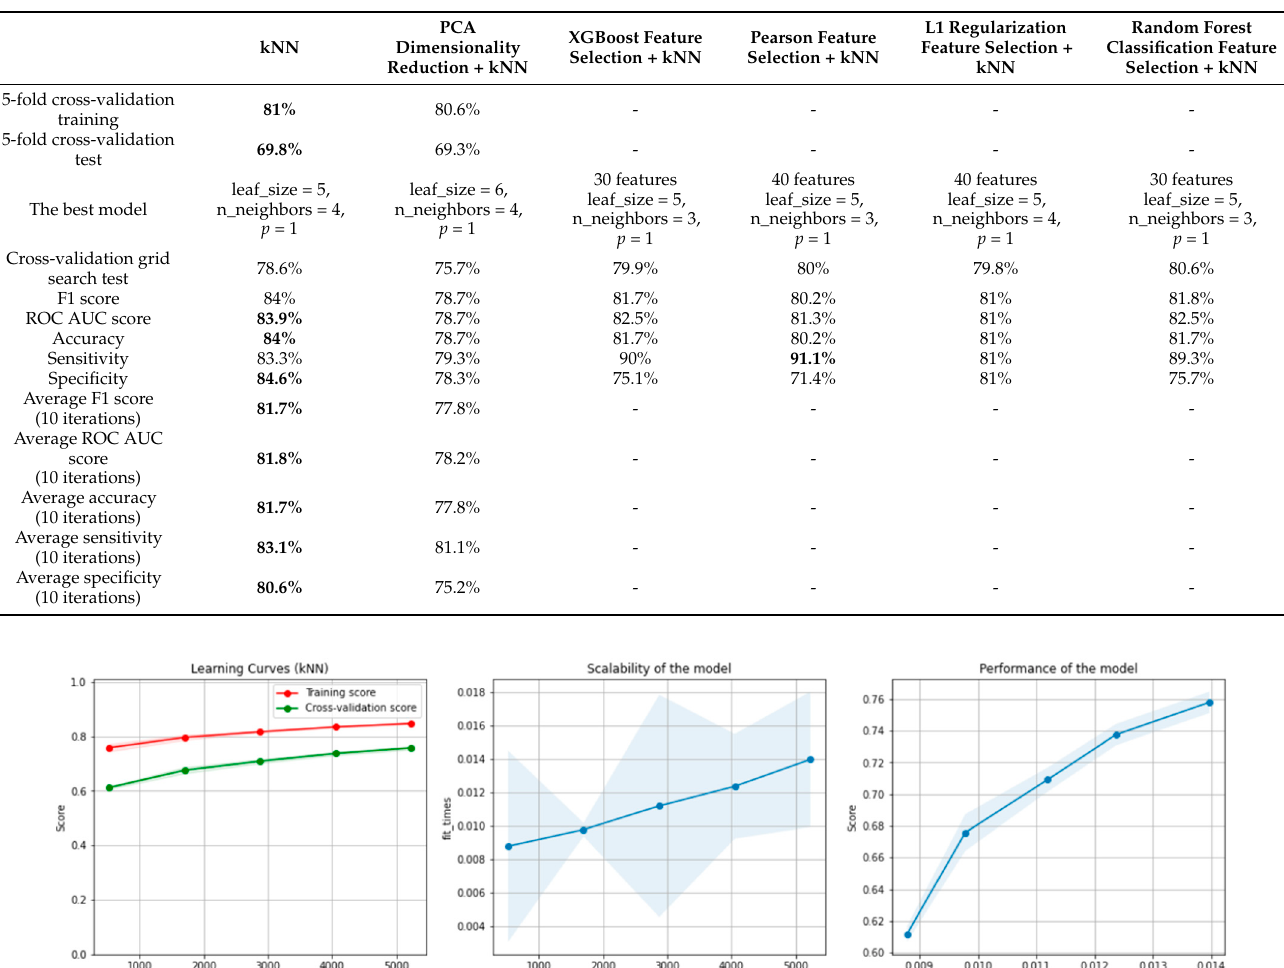
Table 7. Results of the kNN algorithm applied on the overlapping dataset.